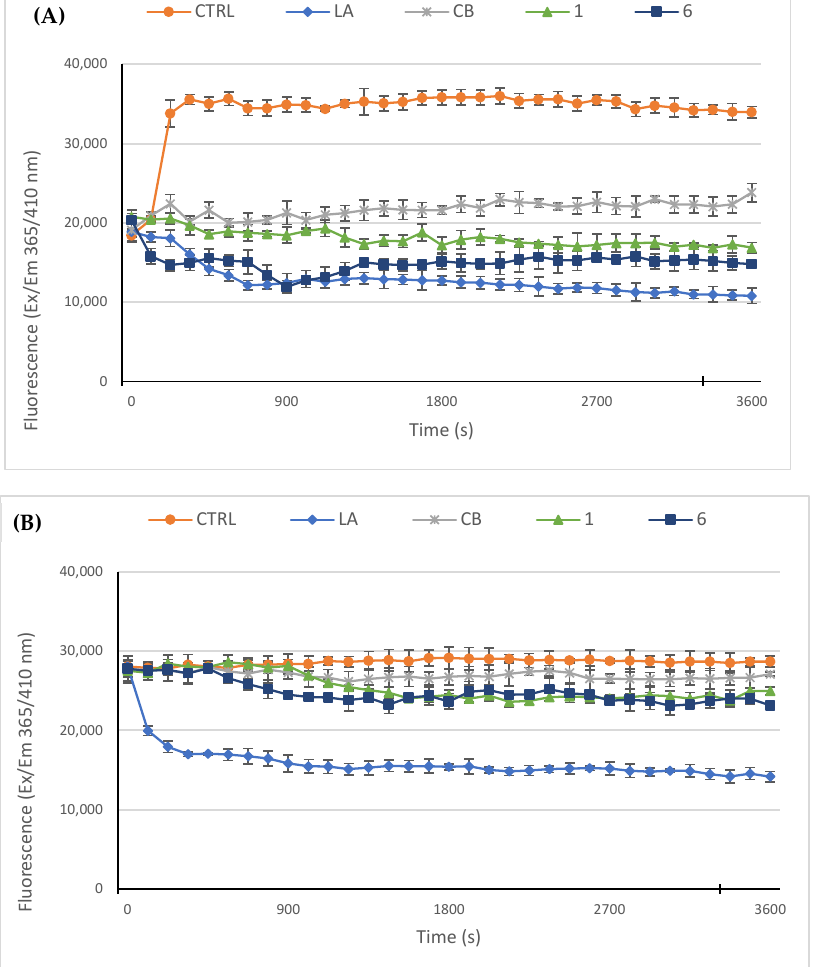
Figure 5. In vitro actin polymerization/depolymerization assay. The effect of compounds 1 and 6 (5 μM) on in vitro actin polymerization and depolymerization was examined. DMSO was used as a negative control. Actin-targeting agents, latrunculin A (LA) and cytochalasin B (CB), both at the concentration of 5 μM, were used as controls. ( A ) In vitro actin polymerization assay: compounds 1 and 6 were incubated with the labeled rabbit muscle actin in order to verify their ability to inhibit the protein polymerization; ( B ) In vitro actin depolymerization assay: after actin polymerization, the compounds 1 or 6 were added to the reaction mixture, in order to determine their ability to act as depolymerizing agents. For both the assays, the assembly of actin filaments was determined by measuring the fluorescence (Ex/Em: 365/410 nm) in kinetic mode for 1 h at room temperature using a microplate reader. The graphics are representative of three different assays.